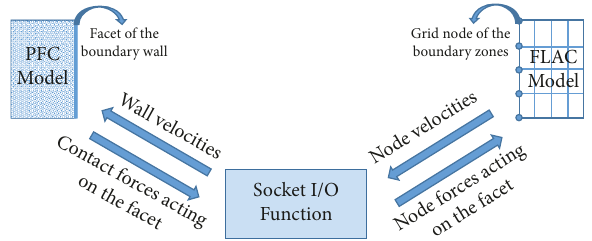
Figure 6: The coupling principle between PFC3D and